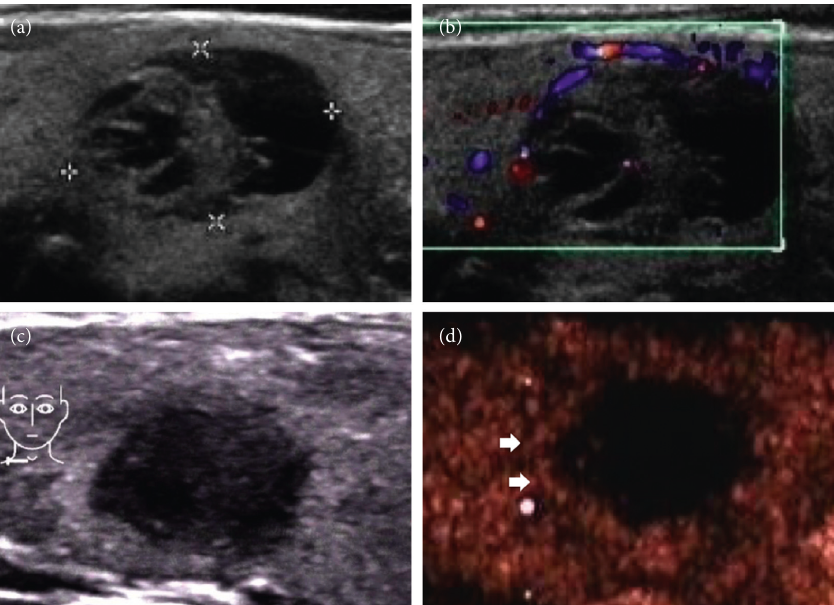
Figure 2: (a, b) A 52-year-old female patient with well-defined cystic and solid nodules in the thyroid gland, and the maximum diameter of the nodules was 17mm. Color Doppler flow imaging showed blood flow signals in the peripheral and internal solid parts. (c) Three years later, the nodule became smaller, the maximum diameter of the nodule was 9mm and the margin of the nodule was irregular. (d) CEUS showed no enhancement in the nodules. Short arrows showed annular enhancement at the edges of the nodules. A clear boundary of the nodules could be seen by careful observation.